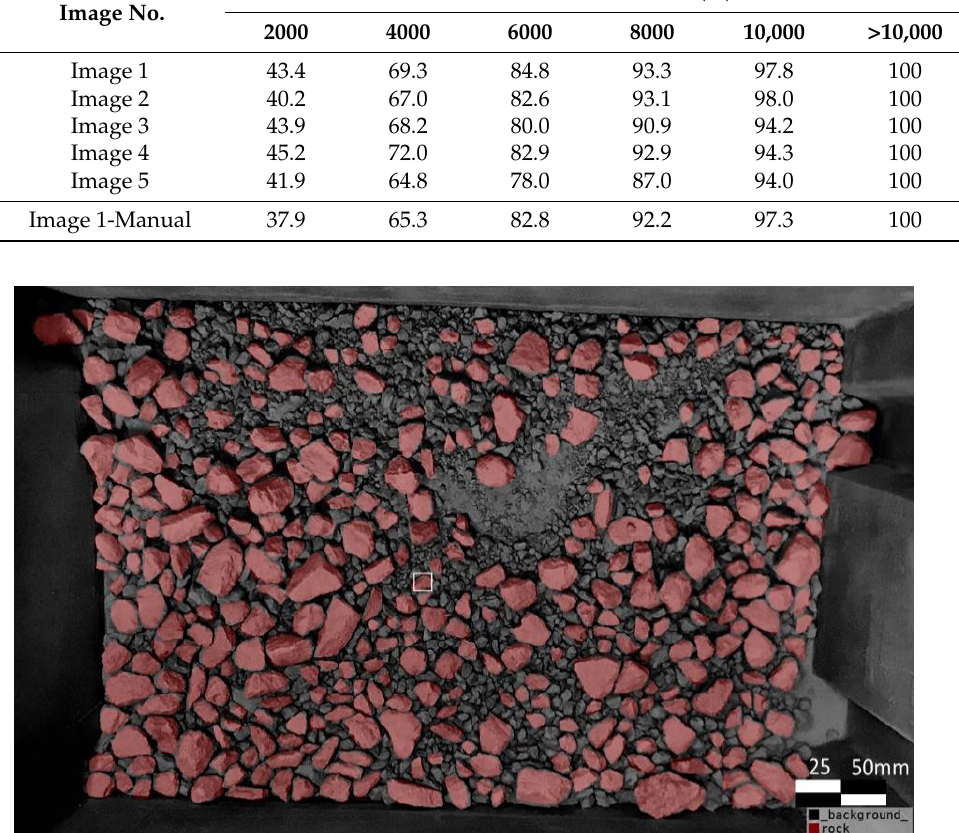
Figure 10. Illustration of manual segmentation of image 1. The white rectangle shows the pixel area of 2000.